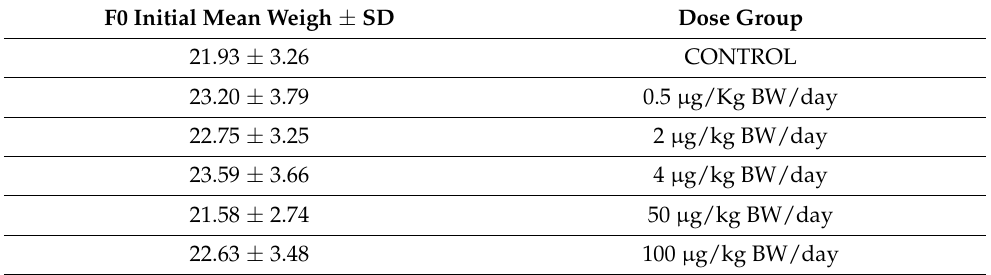
Table 1. Organization and target